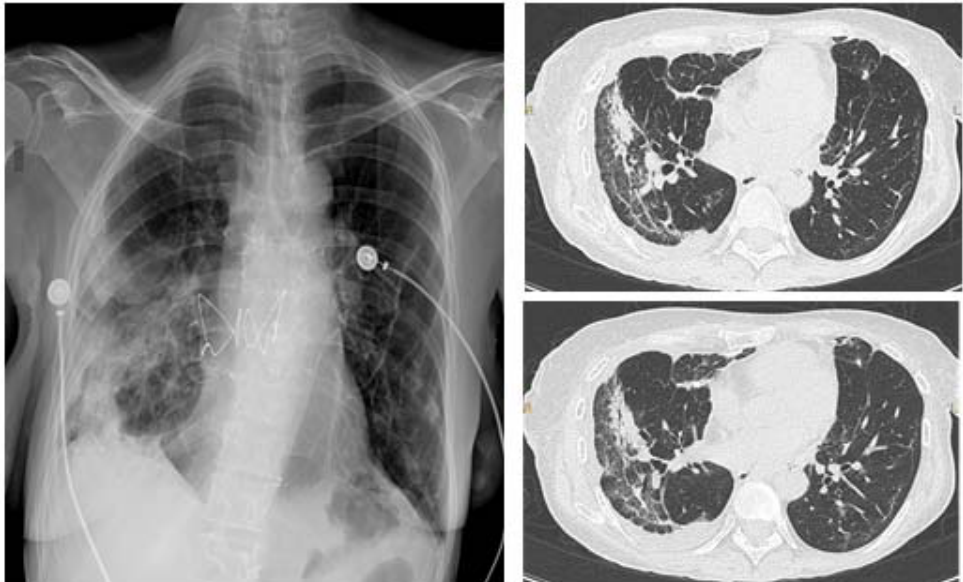
Figure 2. Chest X ‐ ray (CXR) ( left ), CT scan ( right ) of a lung transplanted patient who was infected by SARS ‐ CoV ‐ 2 during the recovery after transplant. The patient underwent a tranbronchial bronchial biopsy and was histologically diagnosed with SARS ‐ CoV ‐ 2 pneumonia.